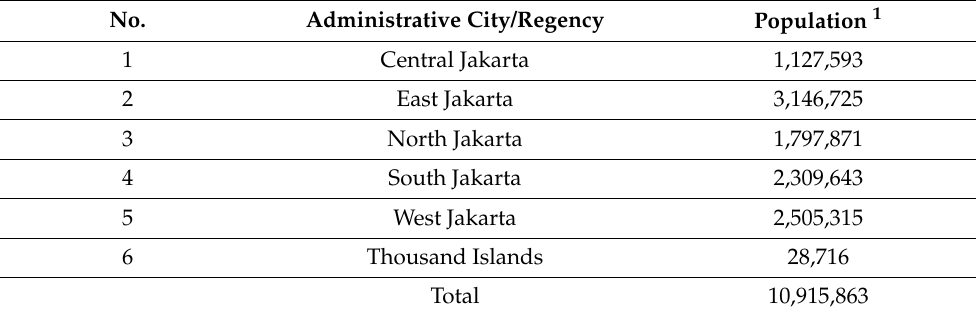
Table 1. Administrative city/regency and population in the province of DKI Jakarta. No. Administrative City/Regency Population 1